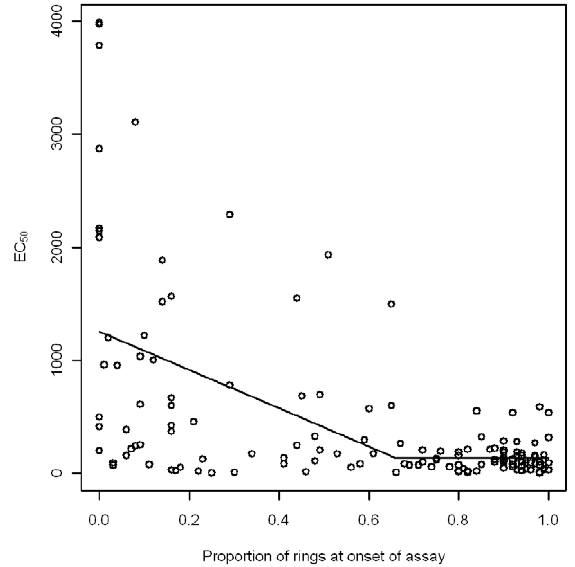
Figure 4. Threshold modelling results for the relationship between the proportion of rings in the initial sample and estimated CQ EC 50 values in P.vivax .